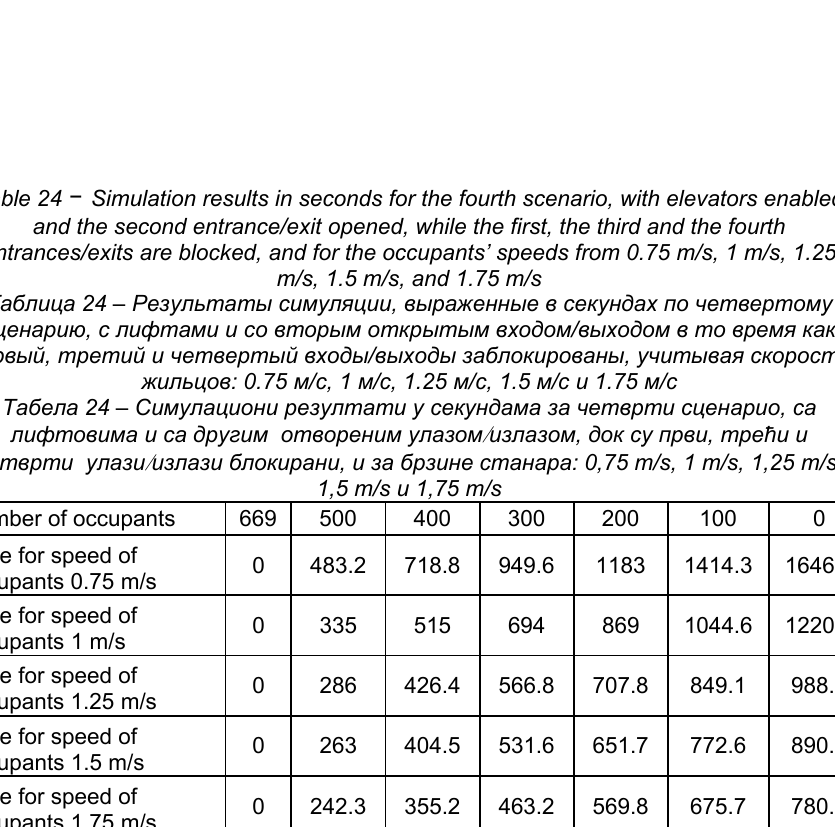
Table 25 – Simulation results in seconds for the fourth scenario, with elevators enabled and the third entrance/exit opened, while the first, the second and the fourth entrances/exits are blocked, and for the occupants’ speeds from 0.75 m/s, 1 m/s, 1.25 m/s, 1.5 m/s, and 1.75 m/s первый , второй и четвертый входы / выходы заблокированы , учитывая скорость